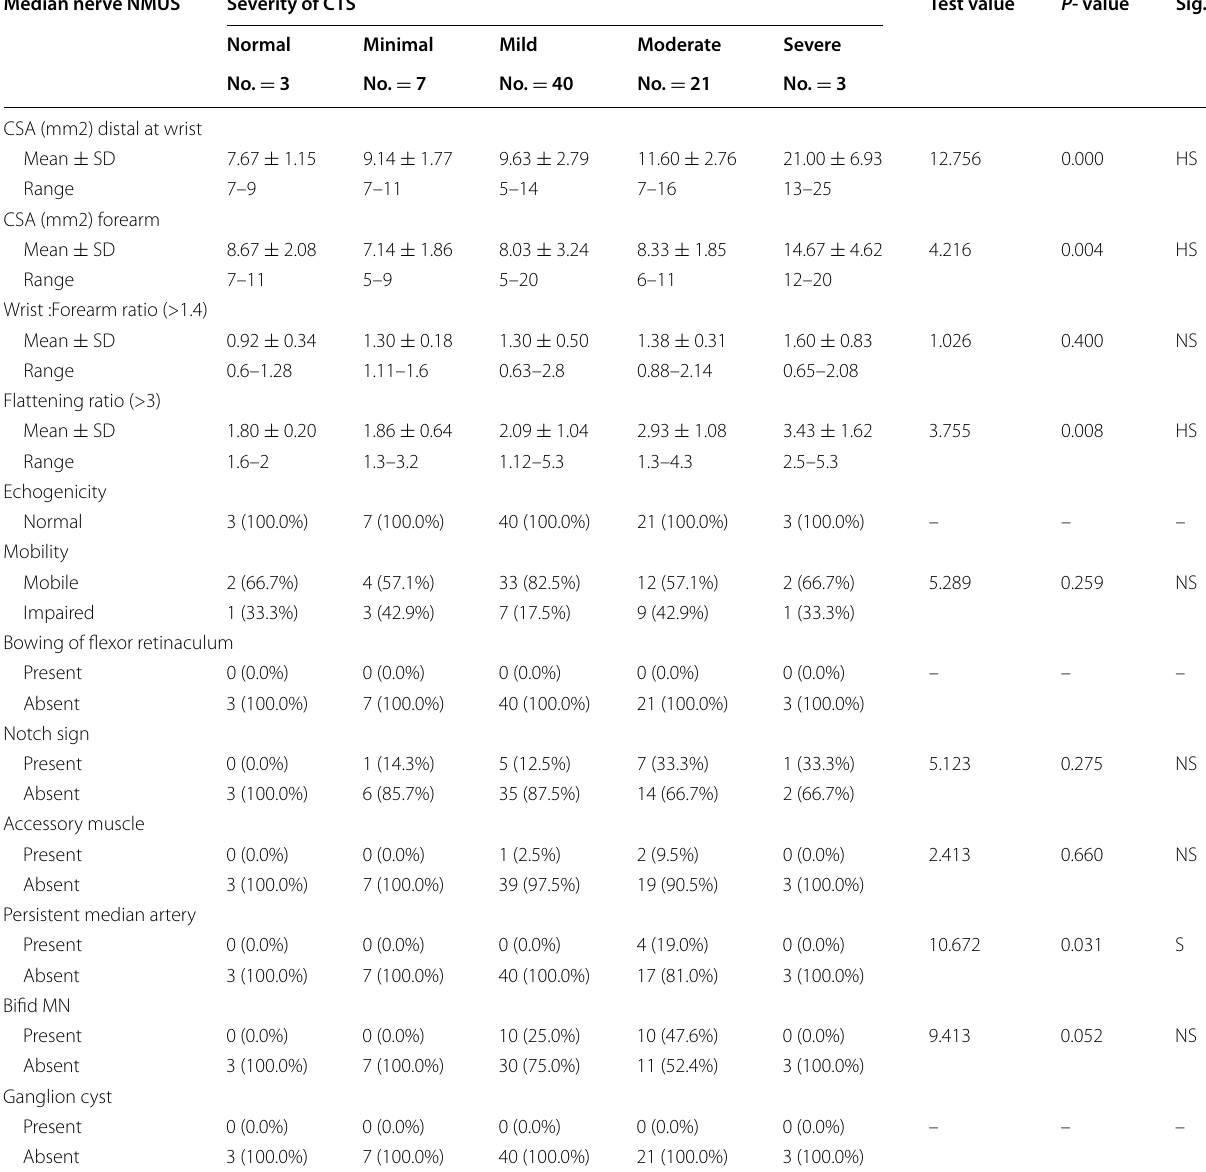
Table 5 Relation between carpal tunnel syndrome severity and neuromuscular ultrasound (NMUS)